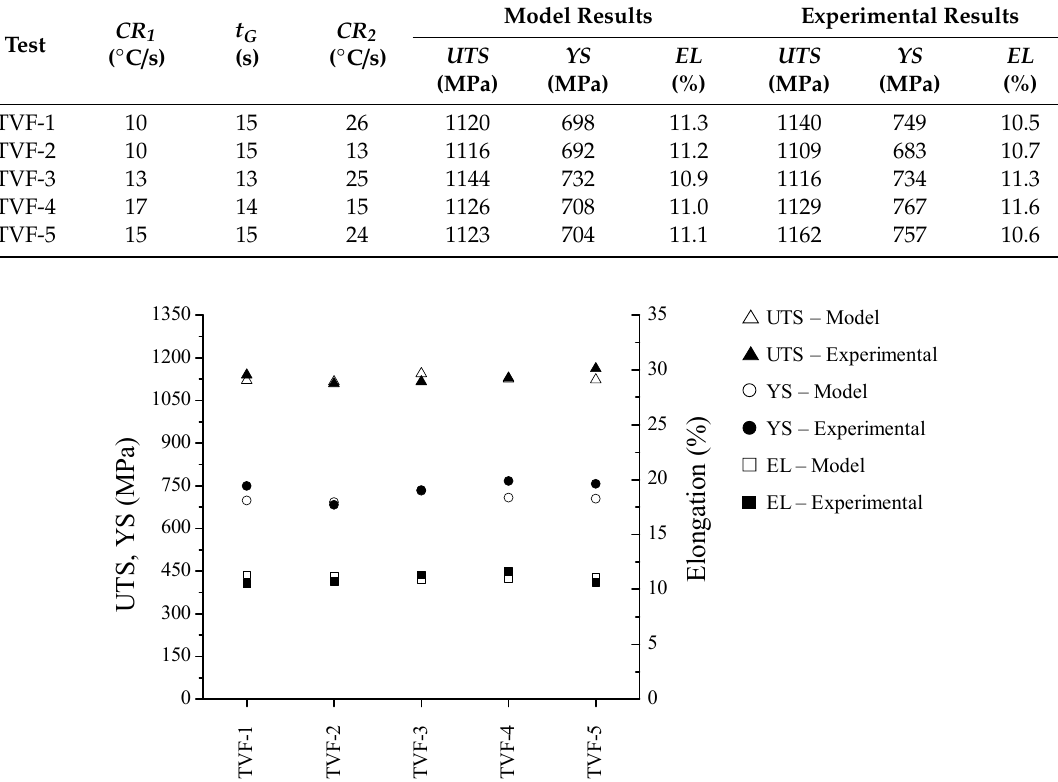
Figure 5. Results of mechanical properties for the experimental tests with optimization results.